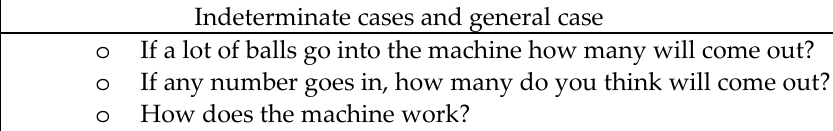
Figure 8. Indeterminate cases and general case used in the interview.